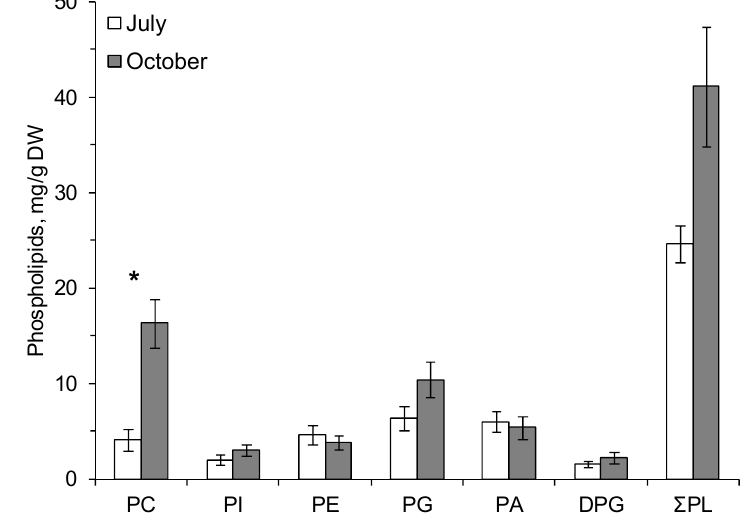
Figure 1. The contents (mg / g dry weight, standard error) of total phospholipids ( Ʃ PL), phosphatidylcholine—PC, phosphatidylinositol—PI, phosphatidylethanolamine—PE, phosphatidylglycerol—PG, phosphatidic acid—PA and diphosphatidylglycerol—DPG in the leaves of Avena sativa on 25.07.2014 (July) and 3.10.2014 (October). *—Significant differences according to Student’s t -test.